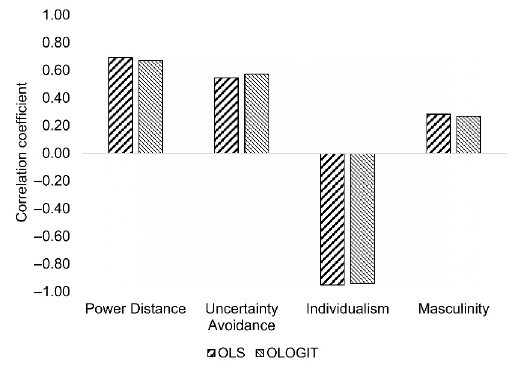
Figure 3. Correlation between the level of culture dimensions of the studied countries and the strength of the impact of entrepreneurial self-efficacy on students’ entrepreneurial